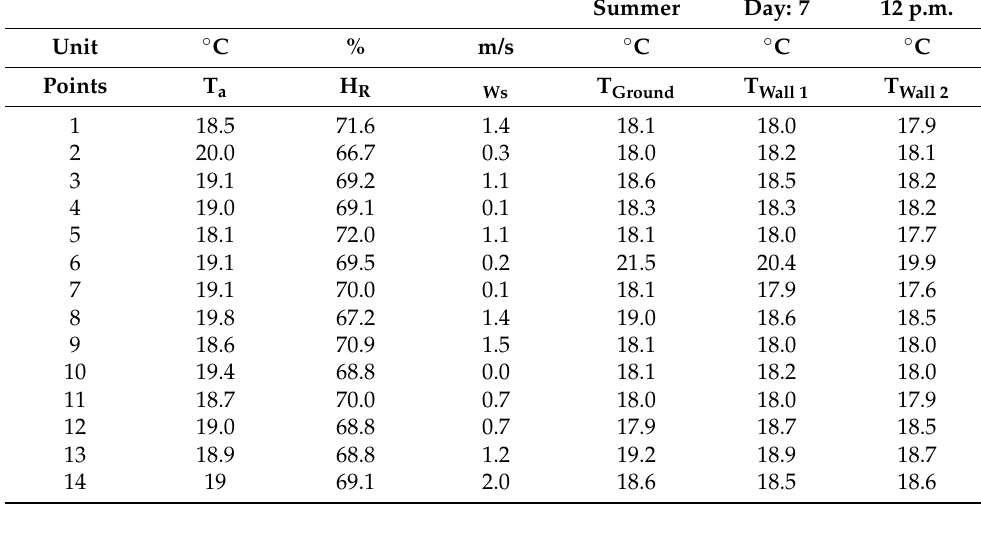
Table 4. Example of measured meteorological data.